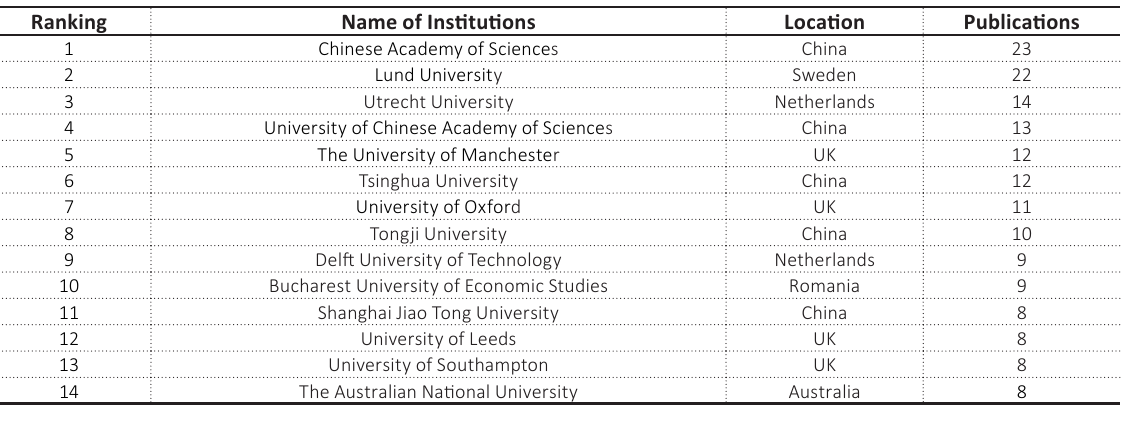
Table 4. Top 14 most contributing organizations on sustainable development in the sharing economy